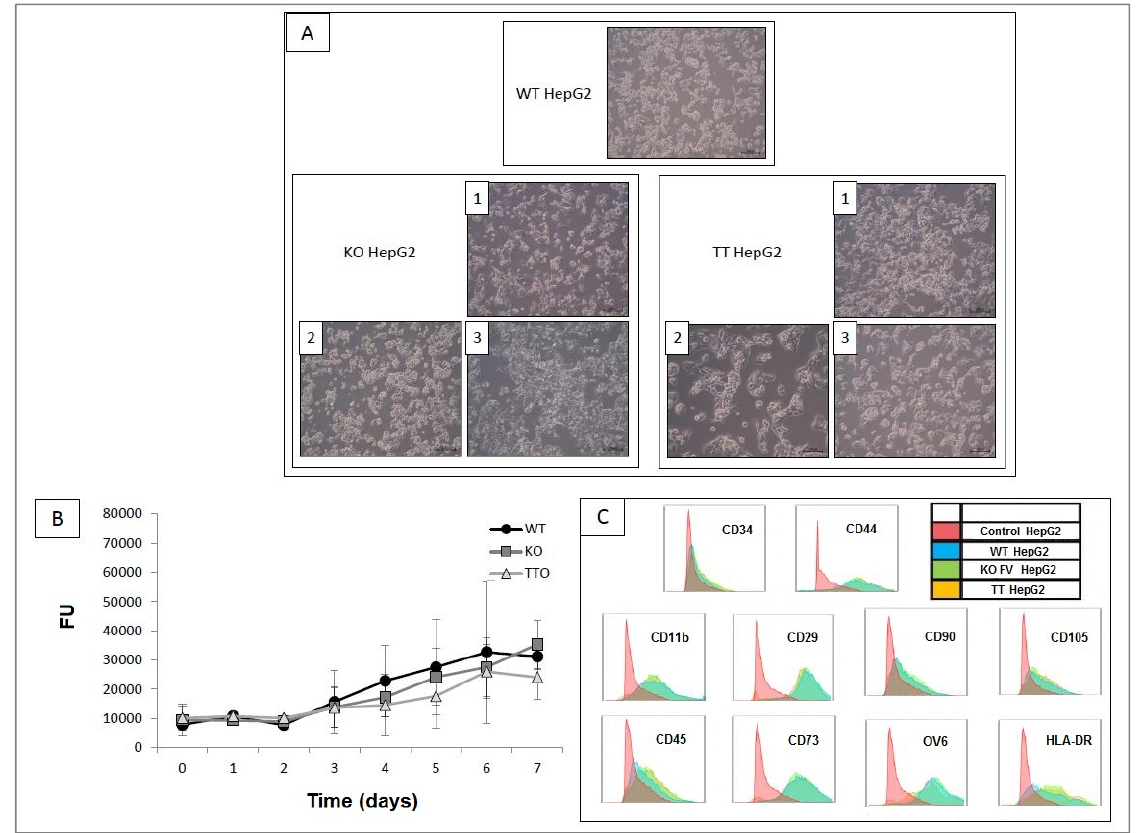
Figure 3. Characterization of different HepG2 lines. ( A ) Morphological changes of different clones (1,2 and 3) (scale bar, 200 μ m). Representative images from different experiments. ( B ) Proliferation curve presented as mean ± SD ( n = 4) (* p ˂ 0.05). ( C ) Flow cytometry for membrane markers: Unstained cells (in red), WT HepG2 (in blue), KO HepG2 (in green) and TT HepG2 (in orange). Representative images from three different experiments.